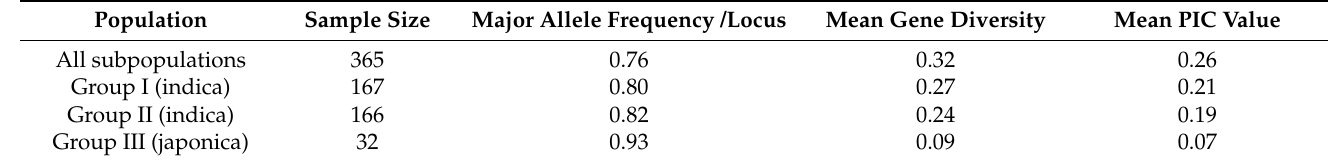
Table 3. Genetic diversity parameters of the three subpopulations grouped by STRUCTURE analysis.